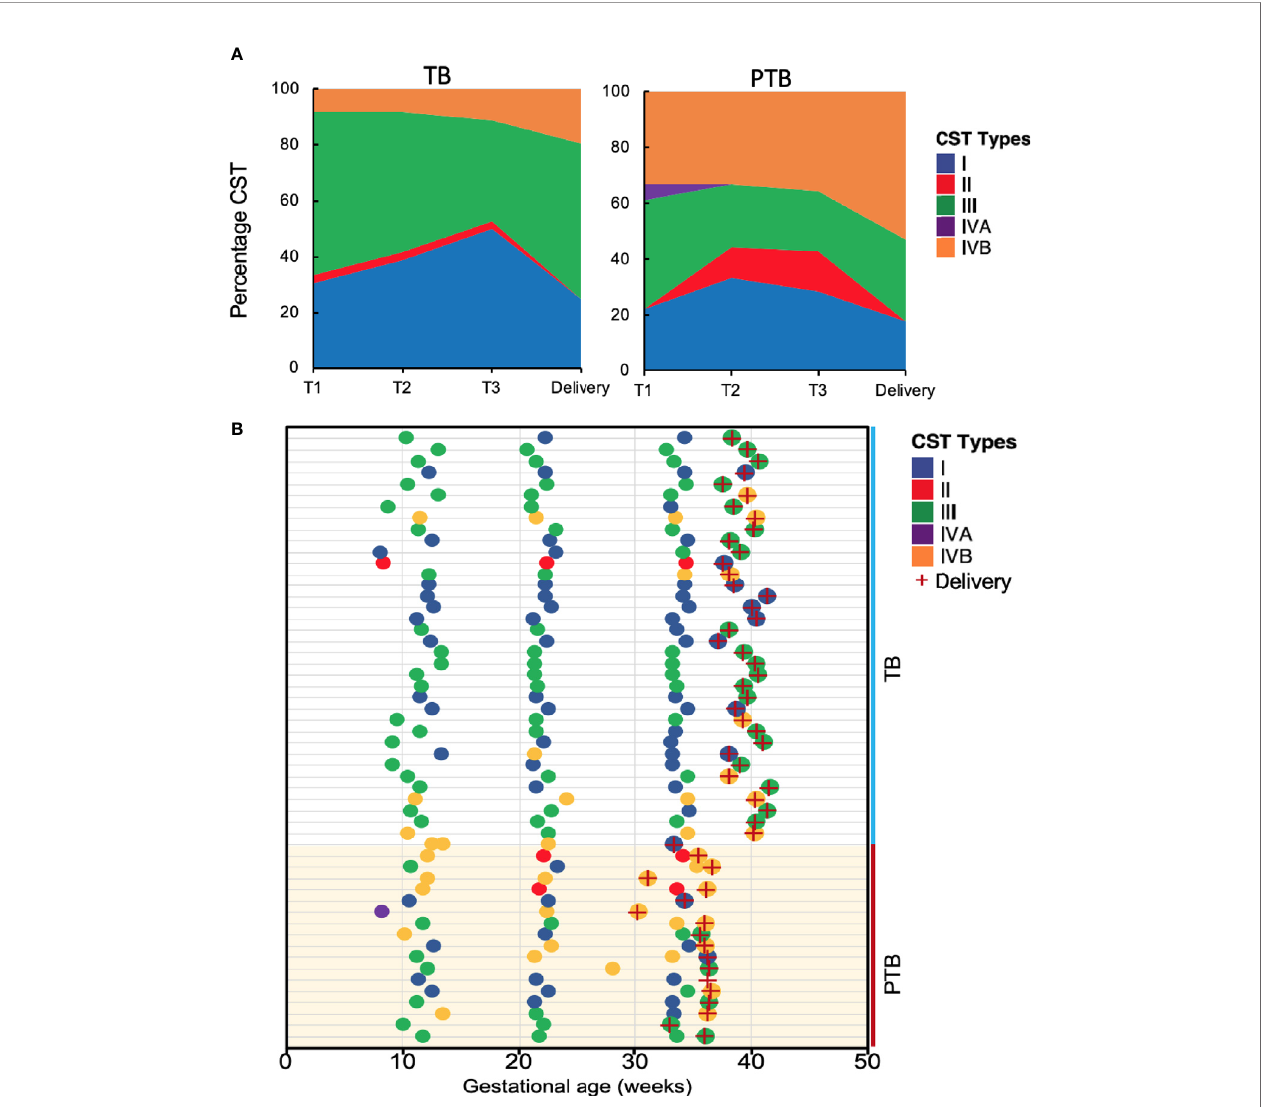
FIGURE 5 | Vaginal community state types during the course of pregnancy. (A) Stacked area charts of community state type (CST) showing the dynamics of the vaginal microbiome in the full term birth (TB) and preterm birth (PTB) groups at the three trimesters of pregnancy (T-1, T-2, T-3) and at delivery. X-axis represents the gestational age T-1: Trimester-1; T-2: Trimester-2; T-3: Trimester-3, y-axis represents the percentage of each CST in the samples from each group. (B) Pro fi les of community state type (CST) for pregnant women who delivered at term (TB) and those who had preterm birth (PTB) as a function of gestational age. Delivery is indicated by a red